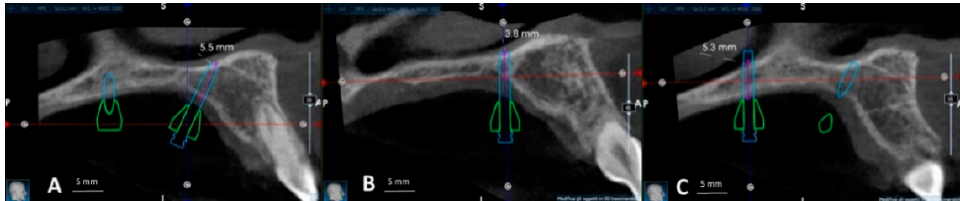
Figure 6. Measurement of bone thickness at miniscrew insertion sites in the patient CBCT with software ruler, and check of miniscrew bicortical engagement. ( A ) Anterior right miniscrew. ( B ) Anterior left miniscrew. ( C ) Posterior miniscrew.